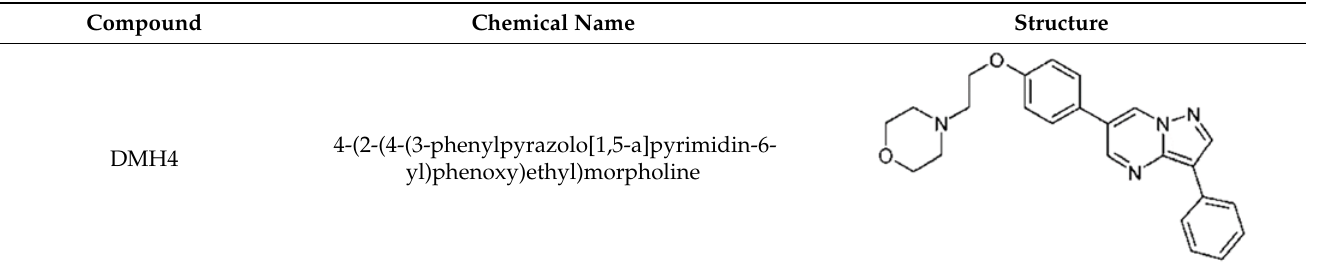
12 of 21 Table 1. Small ‐ molecule BMP inhibitors: Chemical Names and Structures.